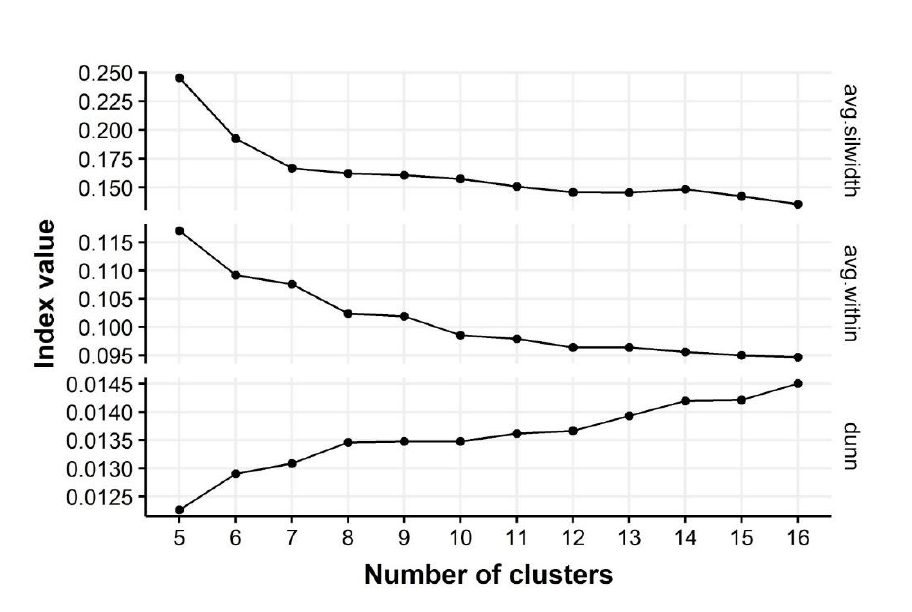
Figure A1.5 . Identification of optimal number of clusters. Representation of three internal validation metrics performance: average silhouette width, average within distance, and dunn index (y axis) along the gradient of number of clusters (x